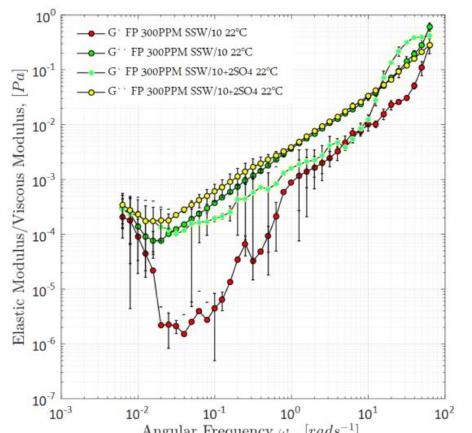
Figure 7. Oscillatory measurements of G (cid:48) and G” as a function of angular frequency for Flopaam 6035 S at 22 ◦ C.